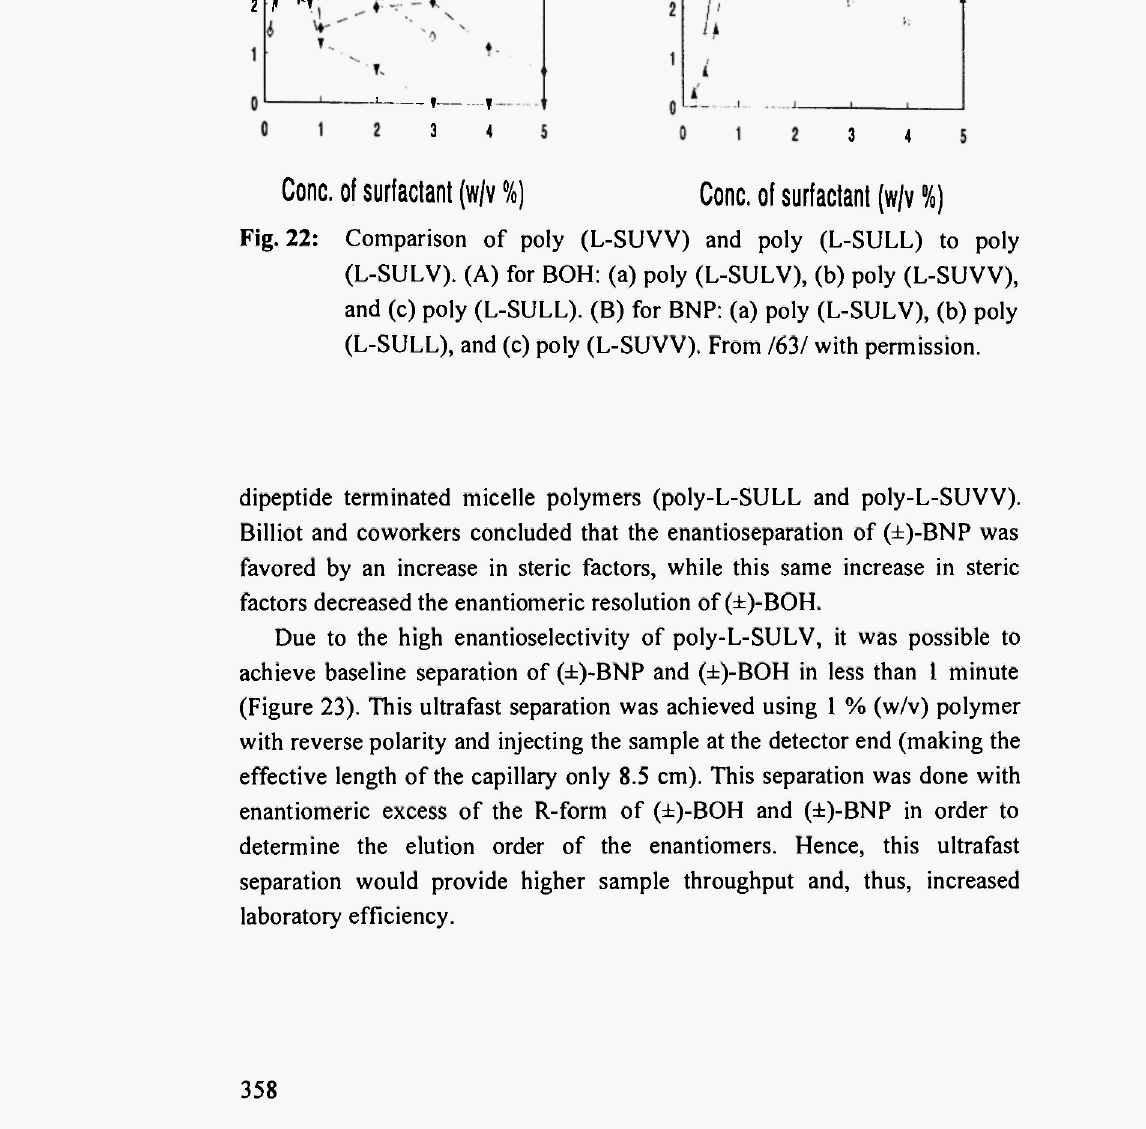
Cone, of surfactant (w/v %) Fig. 22: Comparison of poly (L-SUVV) and poly (L-SULL) to poly (L-SULV). (A) for BOH: (a) poly (L-SULV), (b) poly (L-SUVV), and (c) poly (L-SULL). (B) for BNP: (a) poly (L-SULV), (b) poly (L-SULL), and (c) poly (L-SUVV). From /63/ with